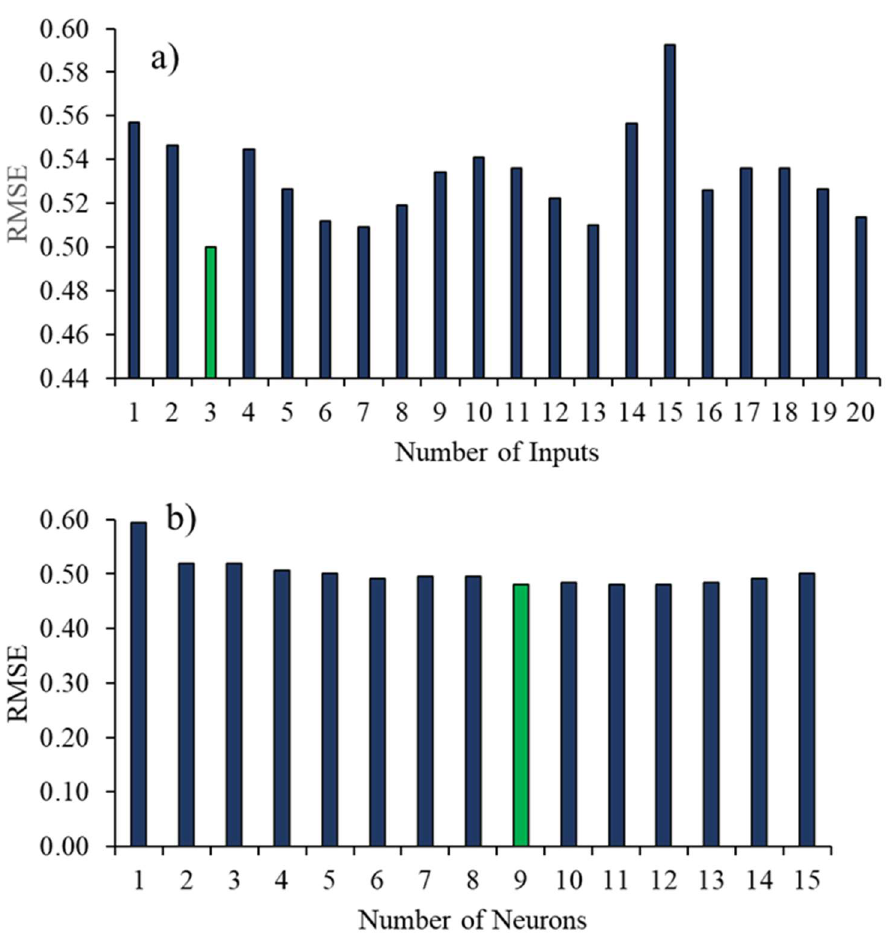
Figure 4. Sample selection of ( a ) input and ( b ) hidden neuron for grid point 4 (refer to Figure 1) SPI-3 ANN model.